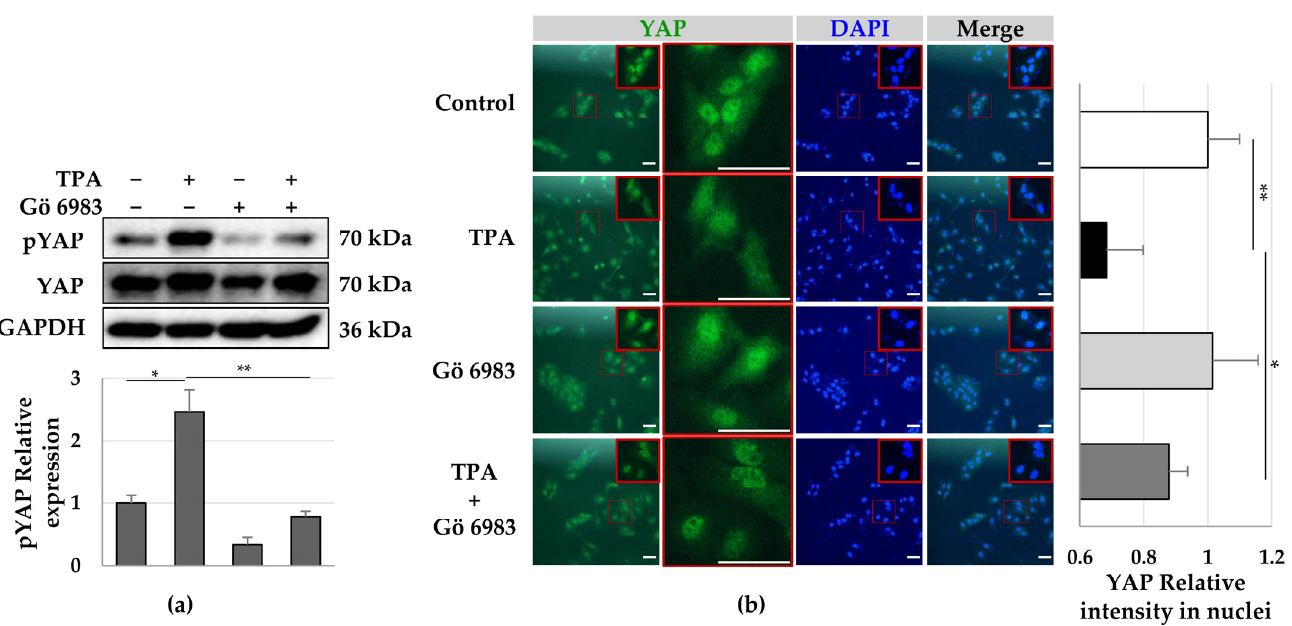
Figure 5. Phosphorylation and cellular distribution of YAP in LX-2 cells treated with TPA or Gö 6983 or both. LX-2 cells were treated with TPA (10 nM) or Gö 6983 (1 µ M) or both for 24 h. The phosphorylation and cellular distribution of YAP were detected using immunoblotting and immunocytochemistry, respectively. ( a ) YAP phosphorylation in LX-2 cells. The intensity of pYAP was quantified using densitometry with Image J and its relative expression was normalized against that of GAPDH. Data are presented as the mean ± SD of three independent experiments. * p ≤ 0.05 and ** p ≤ 0.01. ( b ) Cellular distribution of YAP in LX-2 cells treated with TPA or Gö 6983 or both. The nuclear fluorescence intensity of YAP was quantified using densitometry with Image J. Nuclear fluorescence intensity was analyzed from three random fields, with over 30 cells counted per field. Data are presented as the mean ± SD of three independent experiments. * p ≤ 0.05 and ** p ≤ 0.01. Scale bar, 20 μ m.